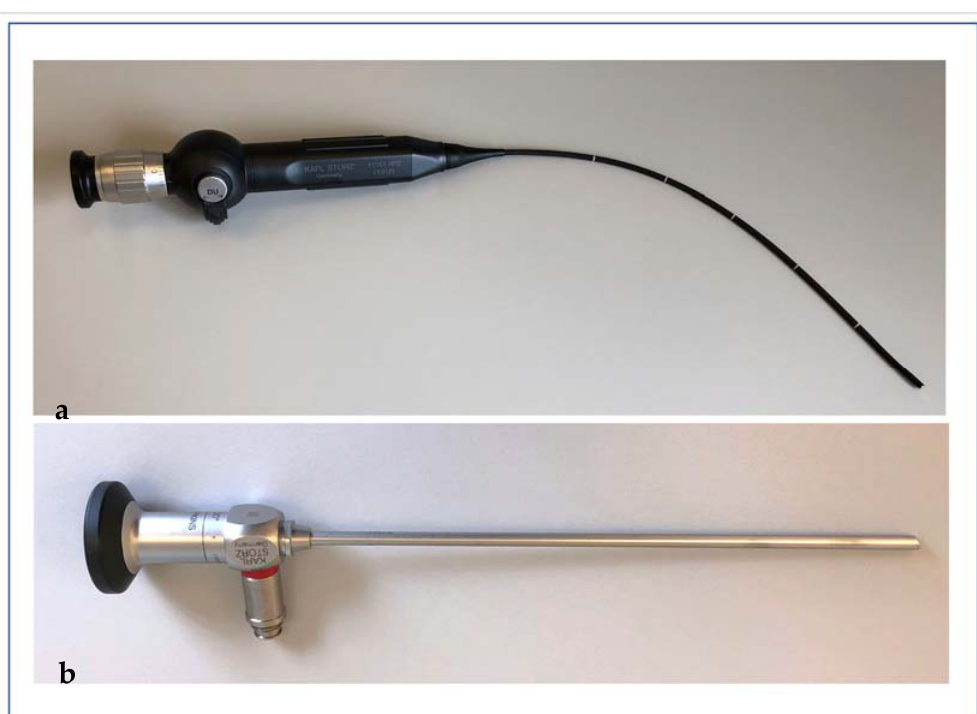
Figure 1. Flexible ( a ) and rigid ( b ) otorhinolaryngological endoscope for examination of the upper aerodigestive tract.